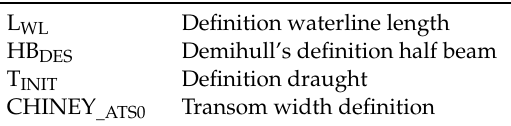
Table 1. Optimization